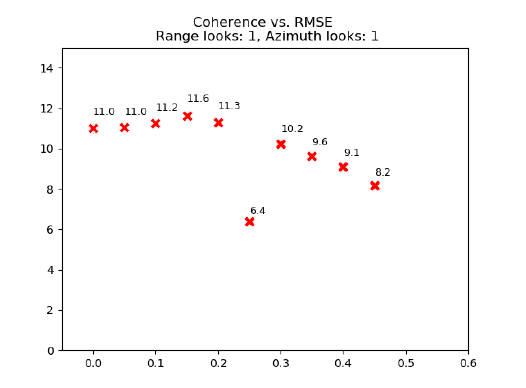
Figure 13. A: Original HV differential interferogram, B: Correc- ted HV interferogram after using the ∆ B ⊥ shown in figure 11. The orbital fringes are not properly corrected; indeed, they get worse.